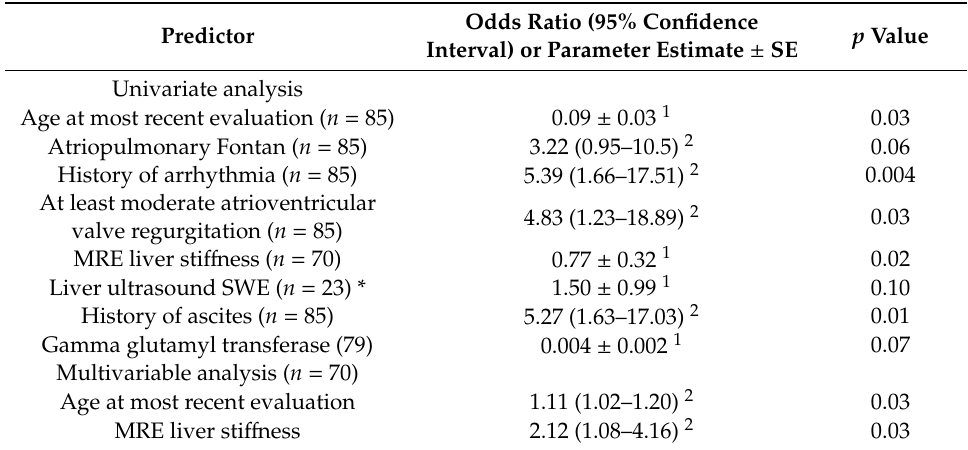
Table 4. Univariate and multivariable predictors of